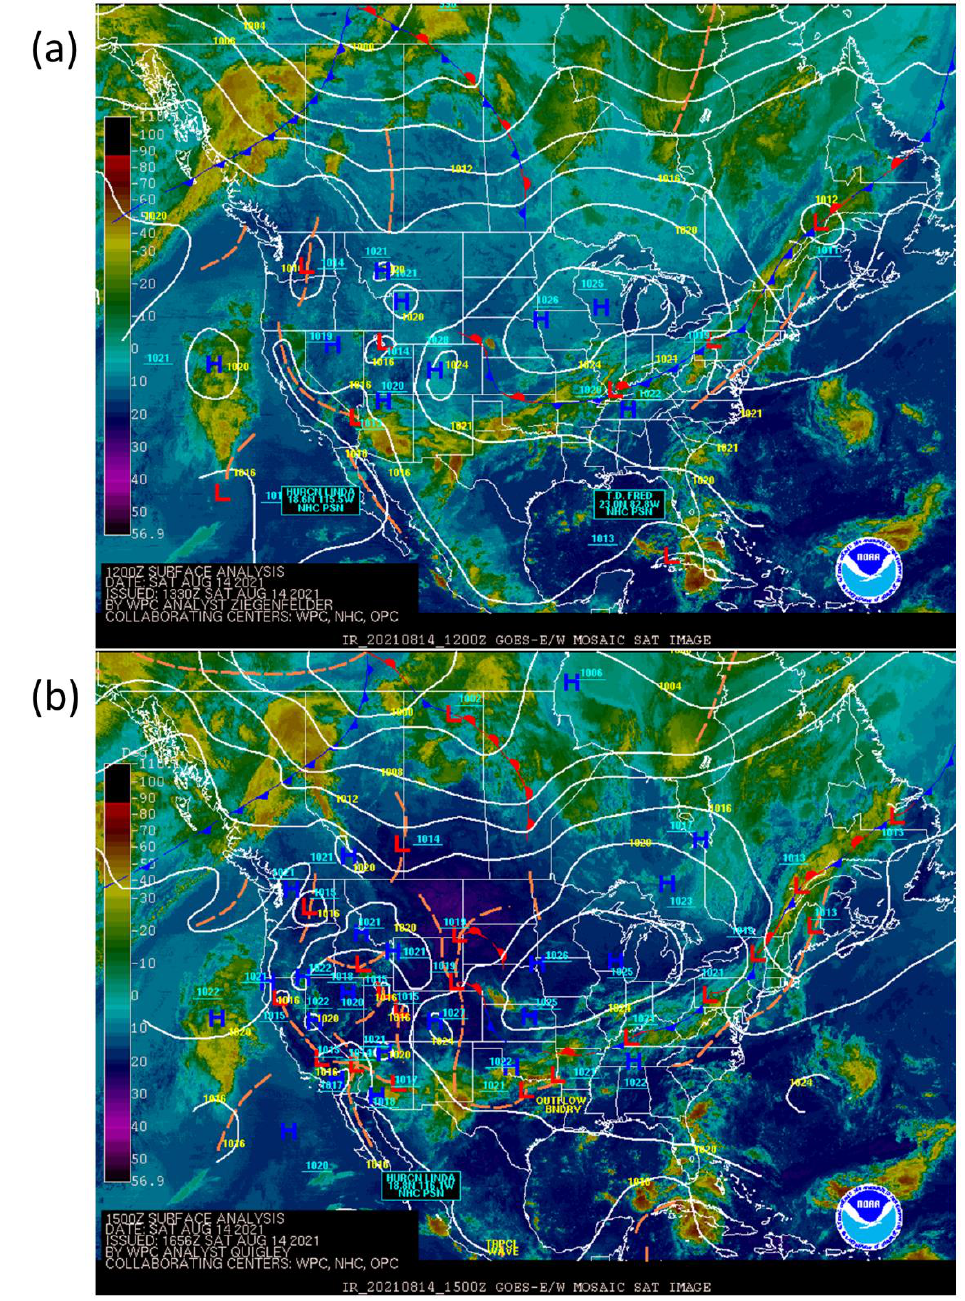
Figure 6. Weather report maps (https://www.wpc.ncep.noaa.gov/archives/web_pages/sfc/sfc_archive.php (accessed on 20 October 2022)) for the 14 August 2021 at 12:00 UT (panel a ) and at 15:00 UT (panel b ).